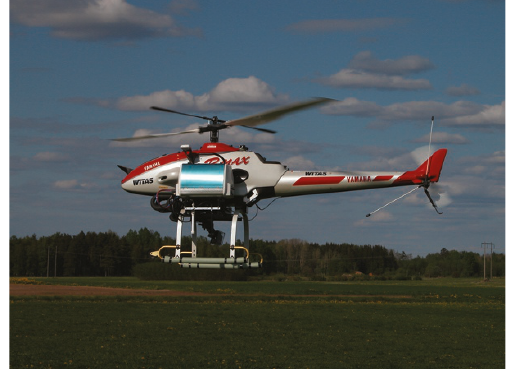
Figure 1: The Rmax helicopter.